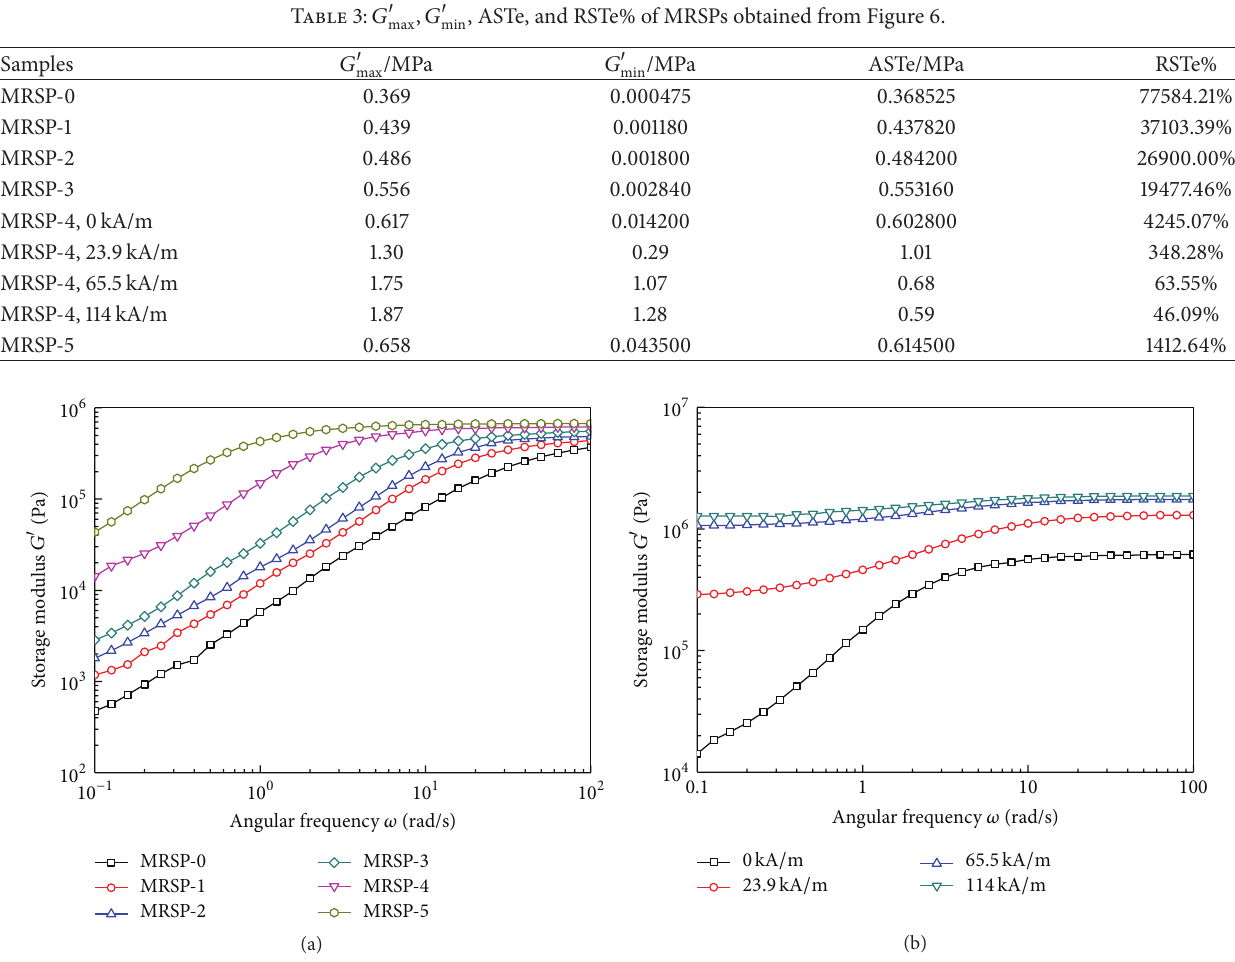
Figure 6: The storage modulus of MRSPs as a function of angular frequency at 25 ∘ C (a) different CI contents and (b) different external magnetic field strength for